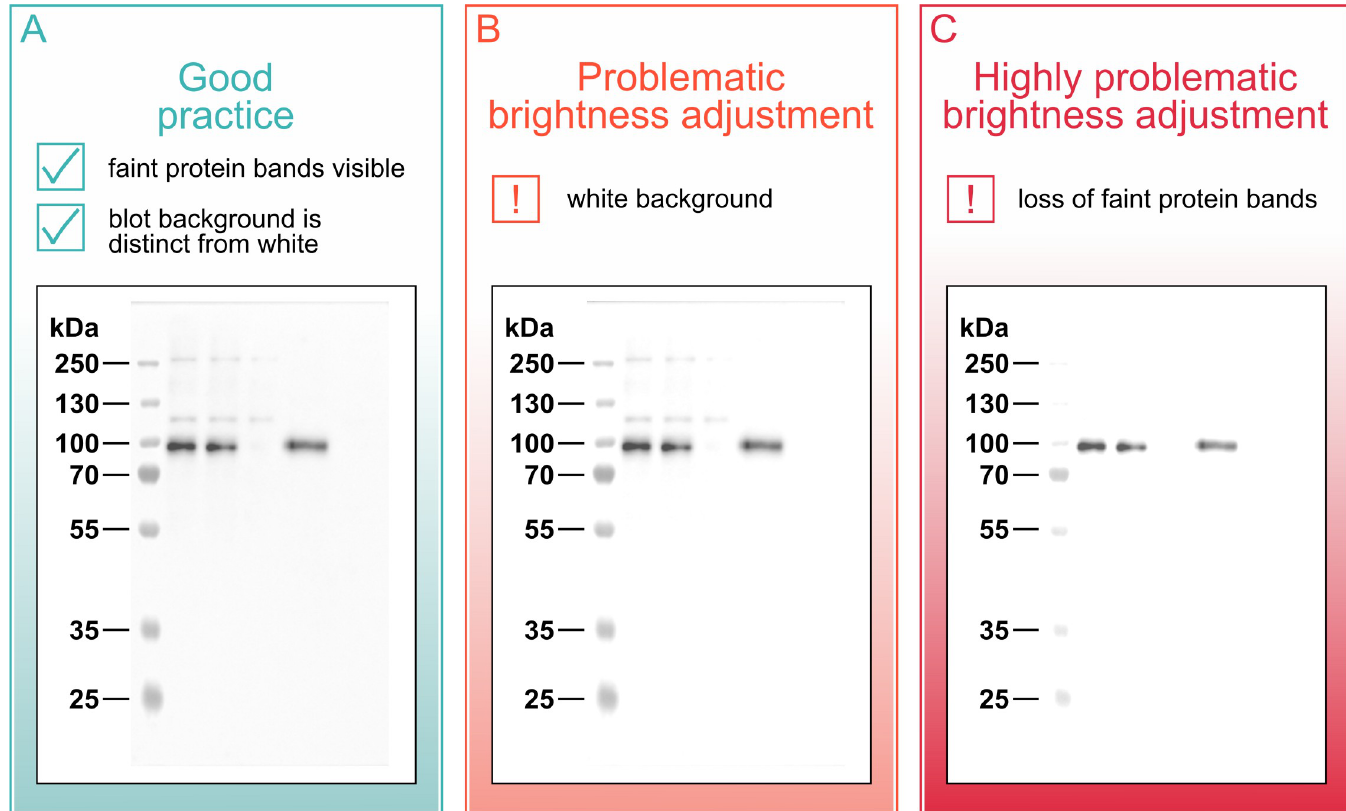
Fig 6. Ensure that the blot background is gray. Good practice: The blot background should be clearly distinguishable from the white page. A gray background provides assurances that the blot has not been lightened excessively. Problematic brightness adjustment: Once any section of the blot background is white, uniform lightening of the blot is no longer possible as the white region is already maximally lightened. Highly problematic brightness adjustment: In extreme cases, excessive nonuniform brightening of the blot can be used to eliminate faint bands. For the unprocessed image, see S1 Fig.